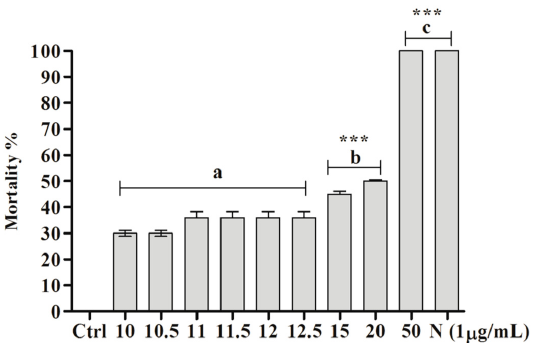
Figure 2. Effect of ether extract (µg/mL) of C. aggregata on B. glabrata embryos: Ctrl—negative